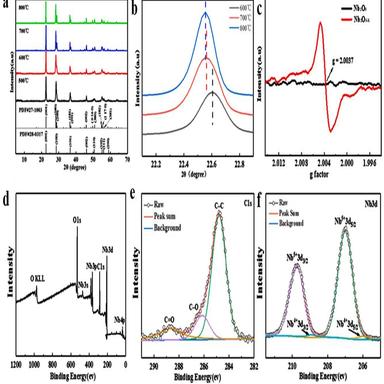
(a) XRD patterns of Nb2O5-x at different temperatures, (b) enlarged views of the (001) diffraction peaks, (c) EPR spectra for Nb2O5 and Nb2O5-x, (d) XPS survey scan of the Nb2O5-x, high resolution XPS spectra of (e) C 1 s, and (f) Nb 3d.